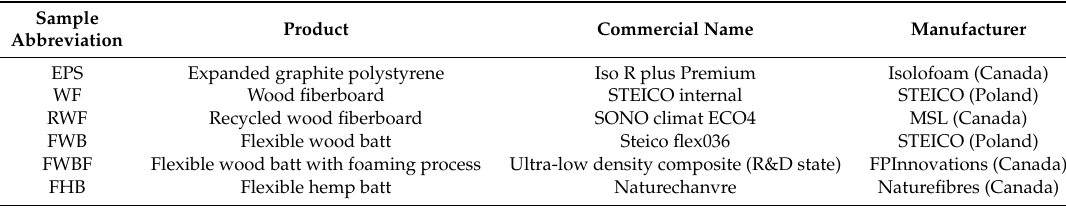
Table 2. Insulation products included for